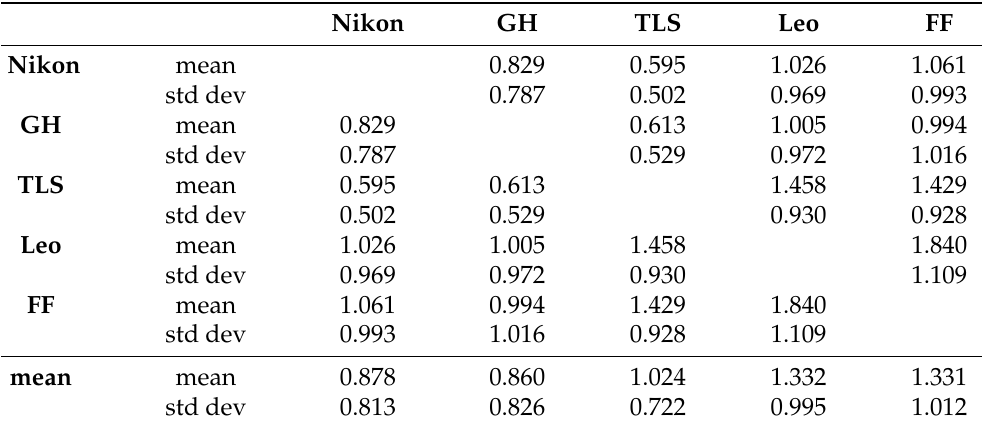
Table 13. Average mean point–point distances and standard deviations as compared across all methods. Numbers are in